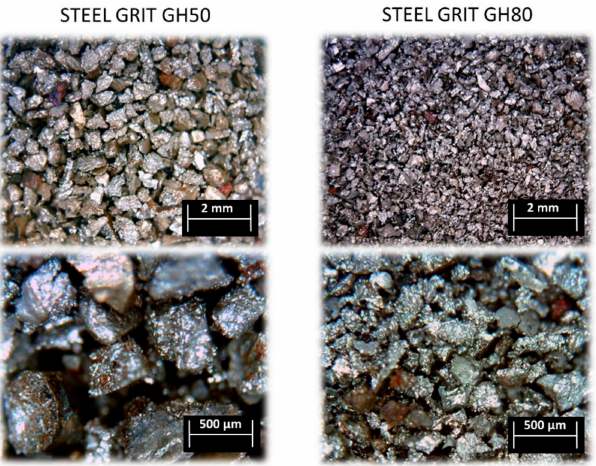
Figure 4. Microscopic photos of the steel abrasive material STEEL GRIT GH50 and Scheme 80.